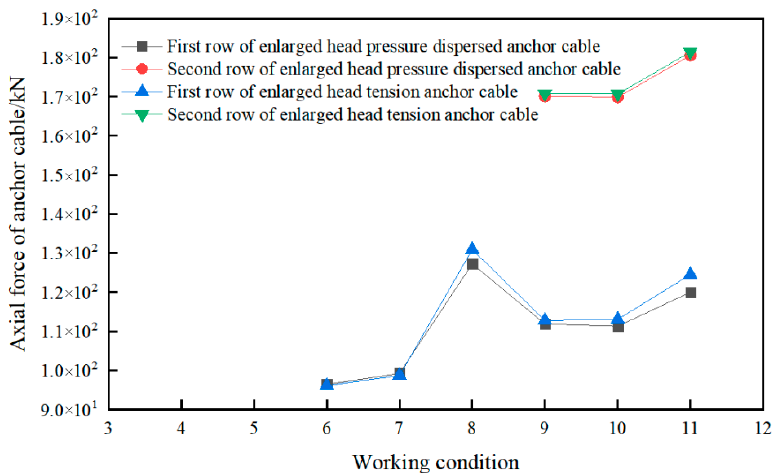
Figure 23. Changes in the anchor cable axial force under different working conditions.